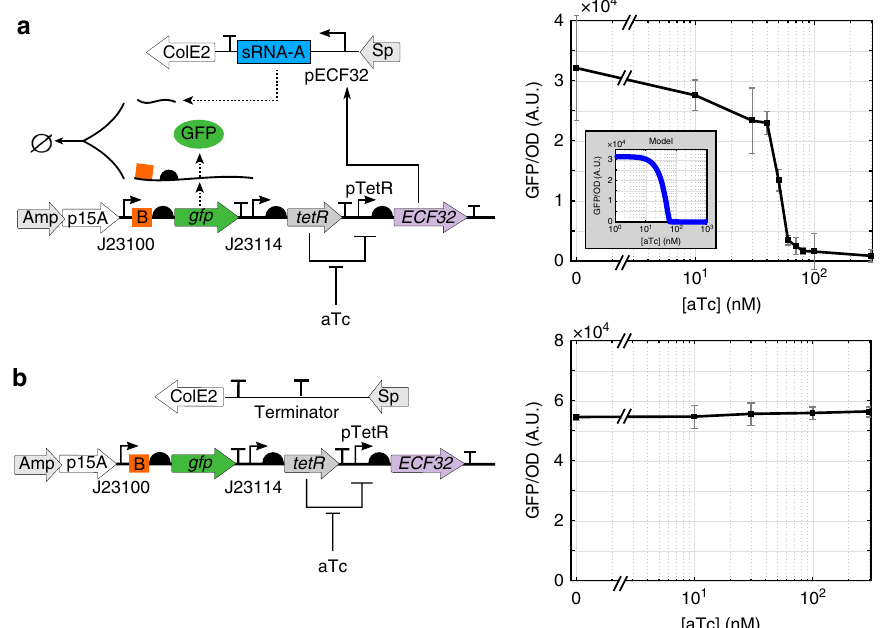
Fig. 4 Con fi rmation of the sRNA-A silencing and the ECF32 actuating mechanisms. a GFP expression is regulated by the sRNA-A silencing and the ECF32 actuating mechanisms. When TetR-regulated ECF32 expression is induced by TetR ’ s effector aTc, ECF32 binds to its cognate promoter pECF32 to transcribe sRNA-A. sRNA-A then antisenses to its targeting sequence (orange B box) on GFP ’ s mRNA to silence GFP expression. Experimental results match well with prediction from the sRNA silencing model in Supplementary Note 10 and Supplementary Fig. 15 (shown in the gray inset box). For [aTc] = 0, 10, 30, 100, 300 nM, data represent the mean (±standard deviation) of eight replicates, including two biological replicates each with four technical replicates. For the rest of the aTc concentrations, data represent the mean (±standard deviation) of four replicates, including two biological replicates each with two technical replicates. b When pECF32 promoter and sRNA-A message were removed, GFP expression was not affected by aTc induction. Data were acquired with microplate photometer. GFP per OD values in arbitrary unit (A.U.) at least 8 h after induction were used as steady states to obtain the dose response curves in both panels. The error bars indicate standard deviation of four replicates, including two biological replicates, each with two technical replicates. See Supplementary Fig. 6 for complete experimental temporal responses of the circuit in panel a . Source data are provided as a Source Data fi le.Source Data